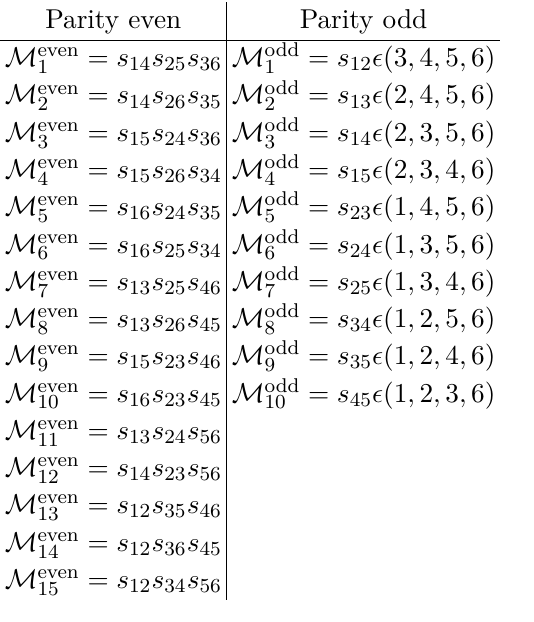
Table 2 . Parity-even and parity-odd amplitude basis for soft blocks at φ 6 D 6